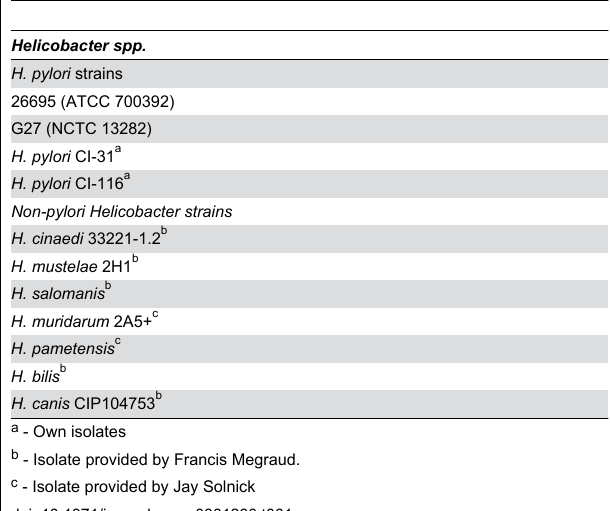
Table 1. Helicobacter strains tested in this